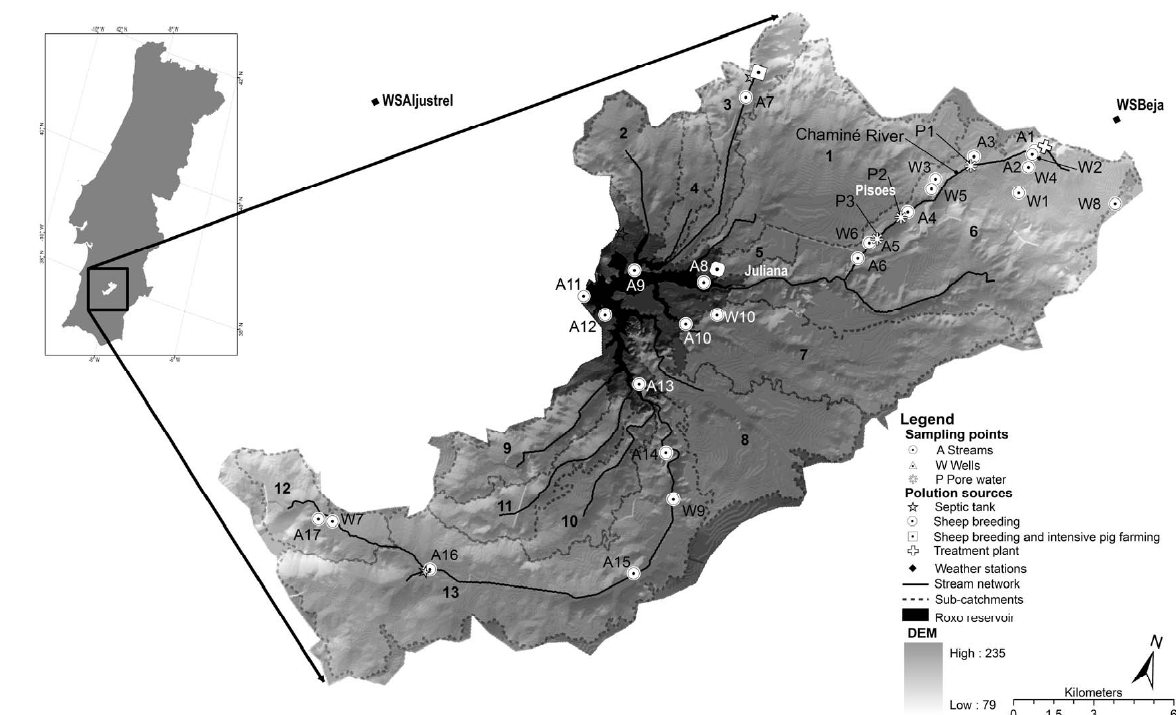
Fig. 1. Map of the study area of Roxo catchment with the principal pollution sources. Circles are the 27 sampling sites, including stream water (A), shallow groundwater (W) and pore water samples